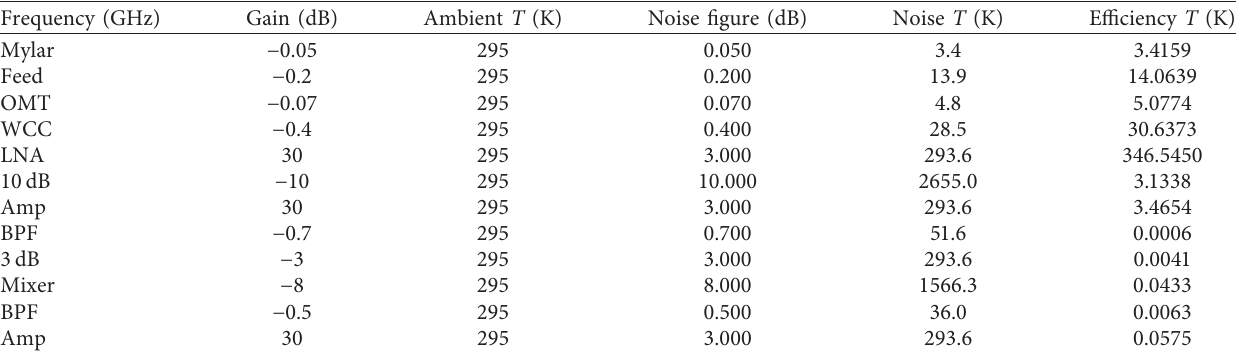
Figure 7: Picture of K-band ambient Table 1: Theoretical calculation of noise temperature for the K-band receiver.